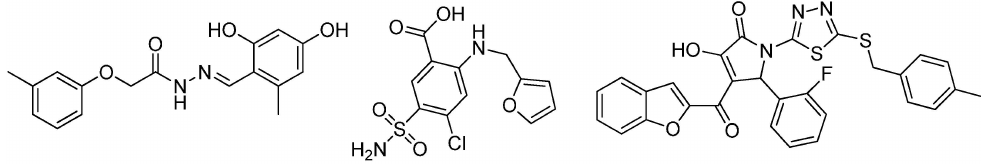
Figure 10. The three new identified scaffolds by Yang et al. [119].